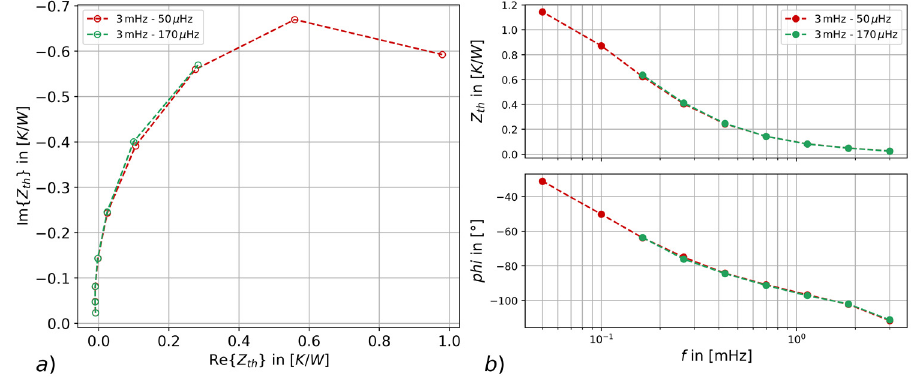
Figure 8. Comparison of two tests using a different lower boundary frequency. ( a ) Nyquist plot; ( b ) corresponding Bode plot; top: amplitude; bottom: phase.